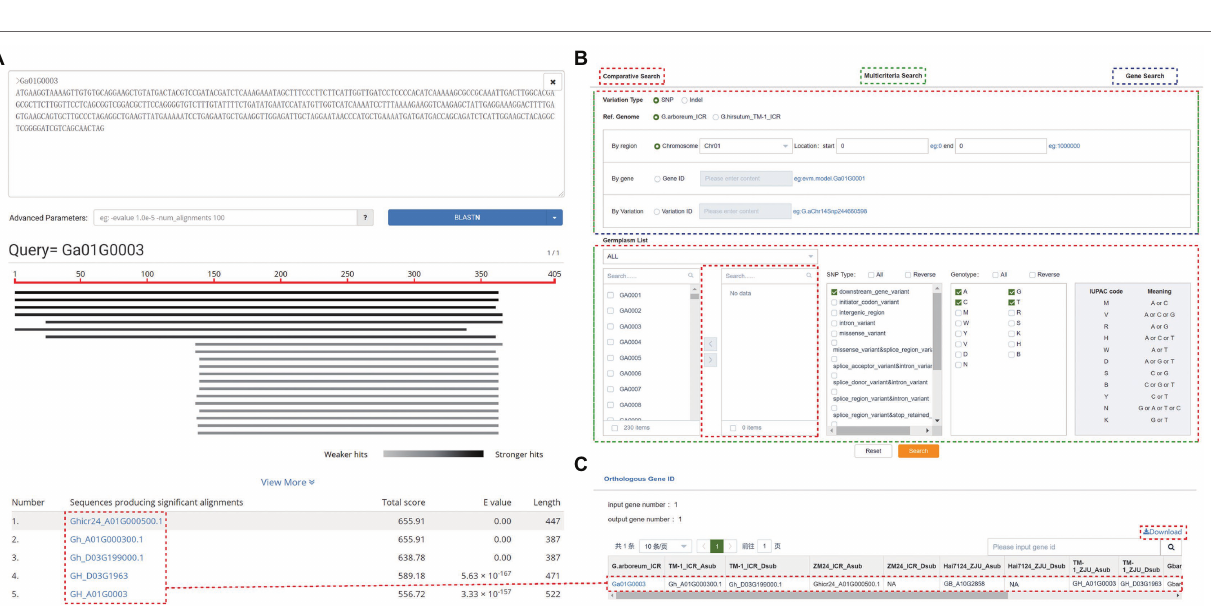
FIGURE 3 | Search functions in GRAND. (A) The results of a BLAST search. (B) The Search page contains Comparative Search, Multicriteria Search, and Gene Search. (C) The orthologous gene ID function allows searching for orthologous gene IDs among different species and versions of cotton